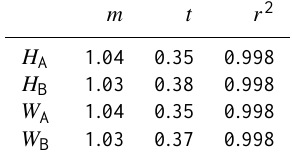
crystals or more of simply shaped pellets or graupel particles.